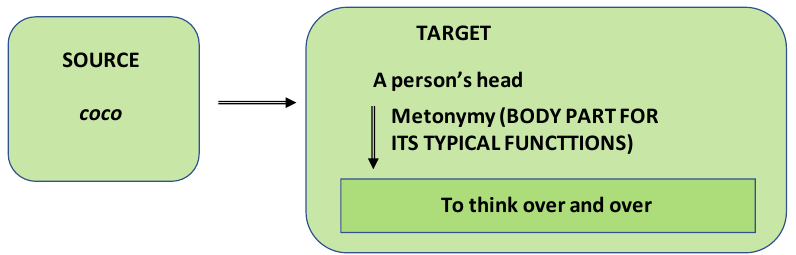
Figure 6. Metonymic reduction of the metaphoric target underlying the interpretation of comerse el coco .